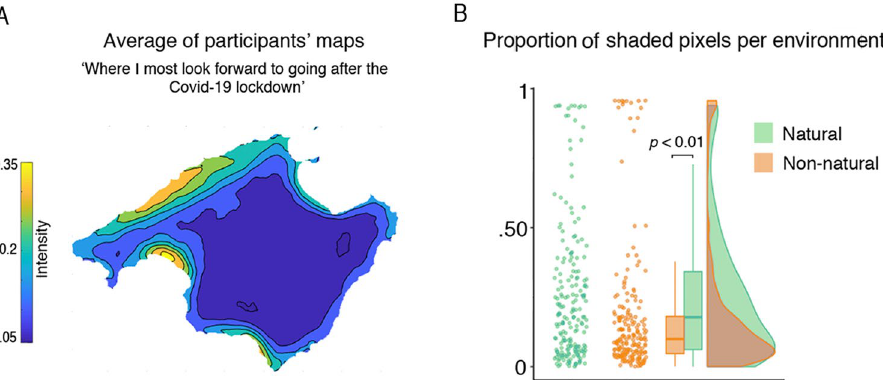
Figure 5. Preference for the environment after Covid-19 lockdown. ( A ) The map depicts the participants’ mean preference for regions to visit after the lockdown. The colorbar denotes the participants’ mean intensity response (warmer coloration for more desired areas). ( B ) The quantification of pixels per environment was computed via Wilcoxon statistical test. This showed that participants’ preference was significantly greater for natural than for non-natural environments ( p < 0.001); n = 201. Outline maps is under Creative Commons license CC0 from